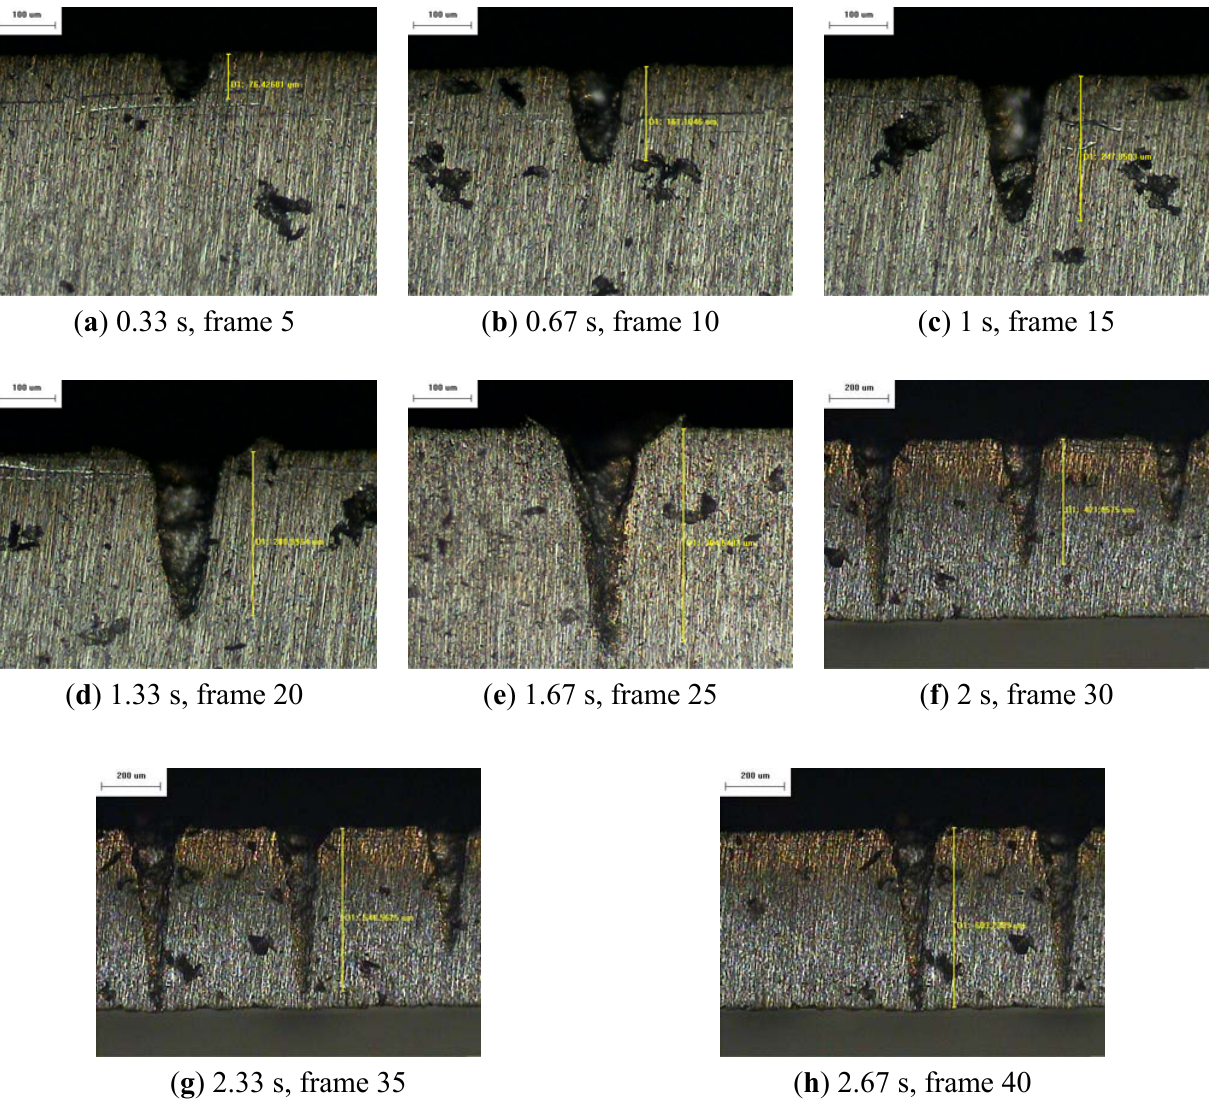
Figure 5. Workpiece (Al 5052) profile images at different process times (radiation energy is 145 mJ): ( a – e ) 100×, ( f – h ) 50×.